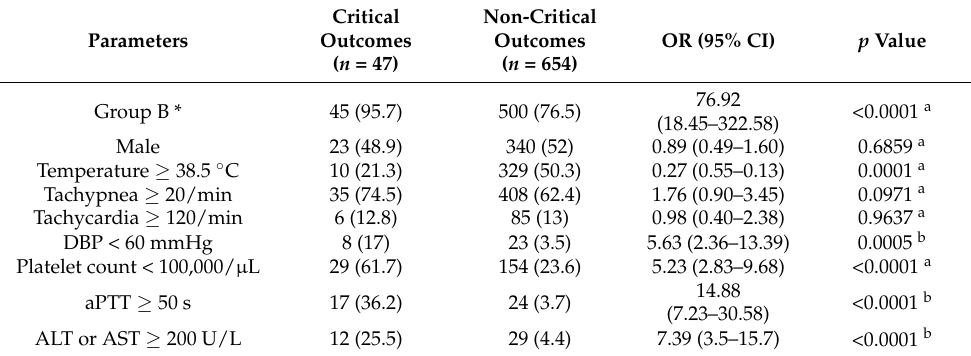
Table 2. Characteristics of the analyzed dengue patients based on their critical